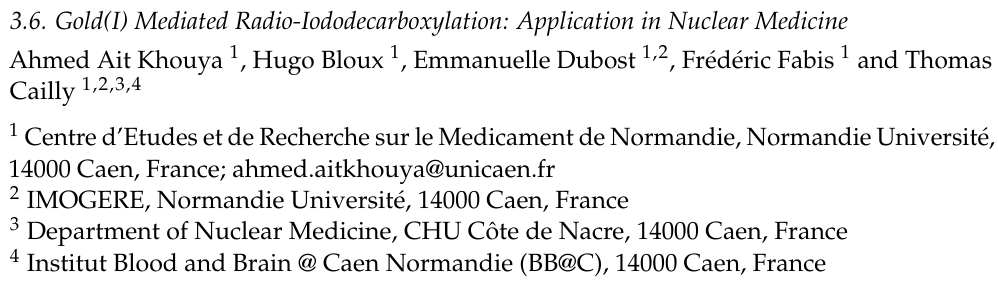
Figure 8. Comparison of lead structure with proposed changes.